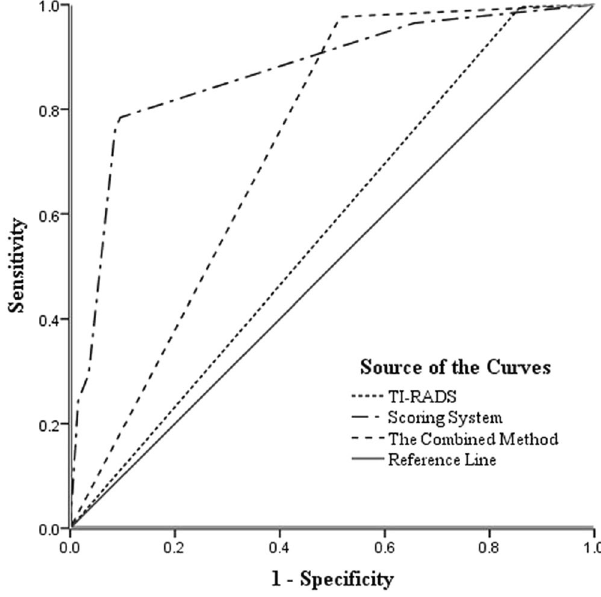
Figure 3. Receiver operating characteristic (ROC) curves of the three